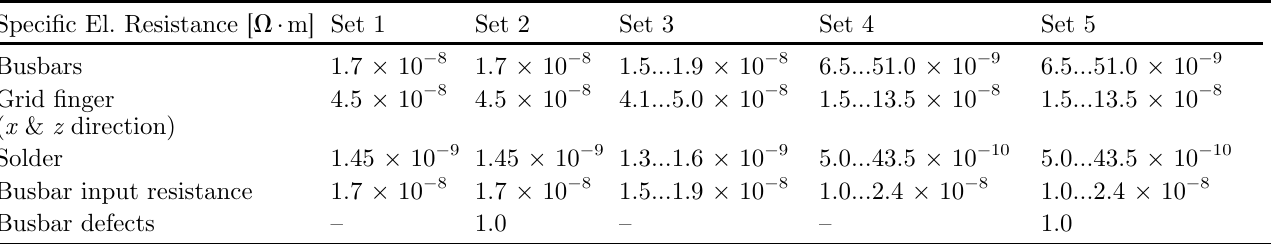
Table 2. Variation of the used speci fi c electric resistances of the FE model parts in the simulation sets for training the neural networks.